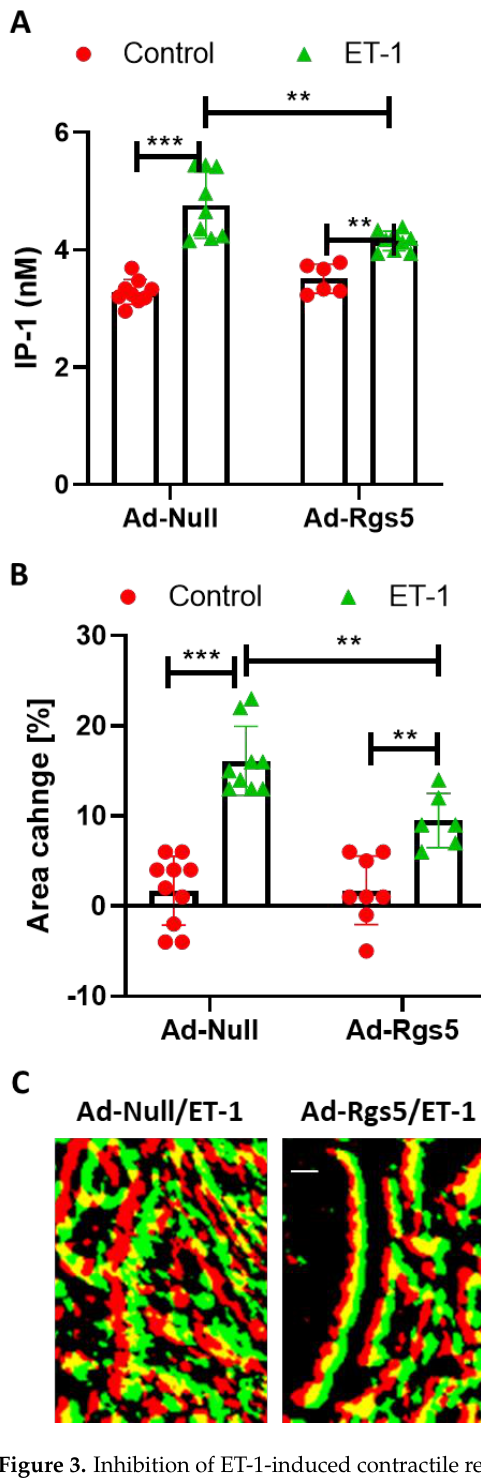
Figure 3. Inhibition of ET-1-induced contractile responses by RGS5. Murine aoSMC were transduced with adenoviral vectors carrying either empty vector (Ad-Null) or Rgs5 (Ad-Rgs5). ( A ) The IP-1 level was measured in three-dimensional spheroids treated with solvent (control) or ET-1 (100 nM, n = 6–9, ** p < 0.01, *** p < 0.001, statistical comparisons as indicated). ( B ) Quantification of area changes of Ad-Null- or Ad-Rgs5-transduced aoSMCs induced by ET-1 (n = 6–10, ** p < 0.01, *** p < 0.001, statistical comparisons as indicated). ( C ) Representative (enlarged) overlay of segments of in Ad-Null- or Ad-Rgs5-transduced aoSMCs stimulated with ET-1 (100 nM, red: before stimulus, green: after stimulus, yellow: overlapping structures, scale bars: 10 µ